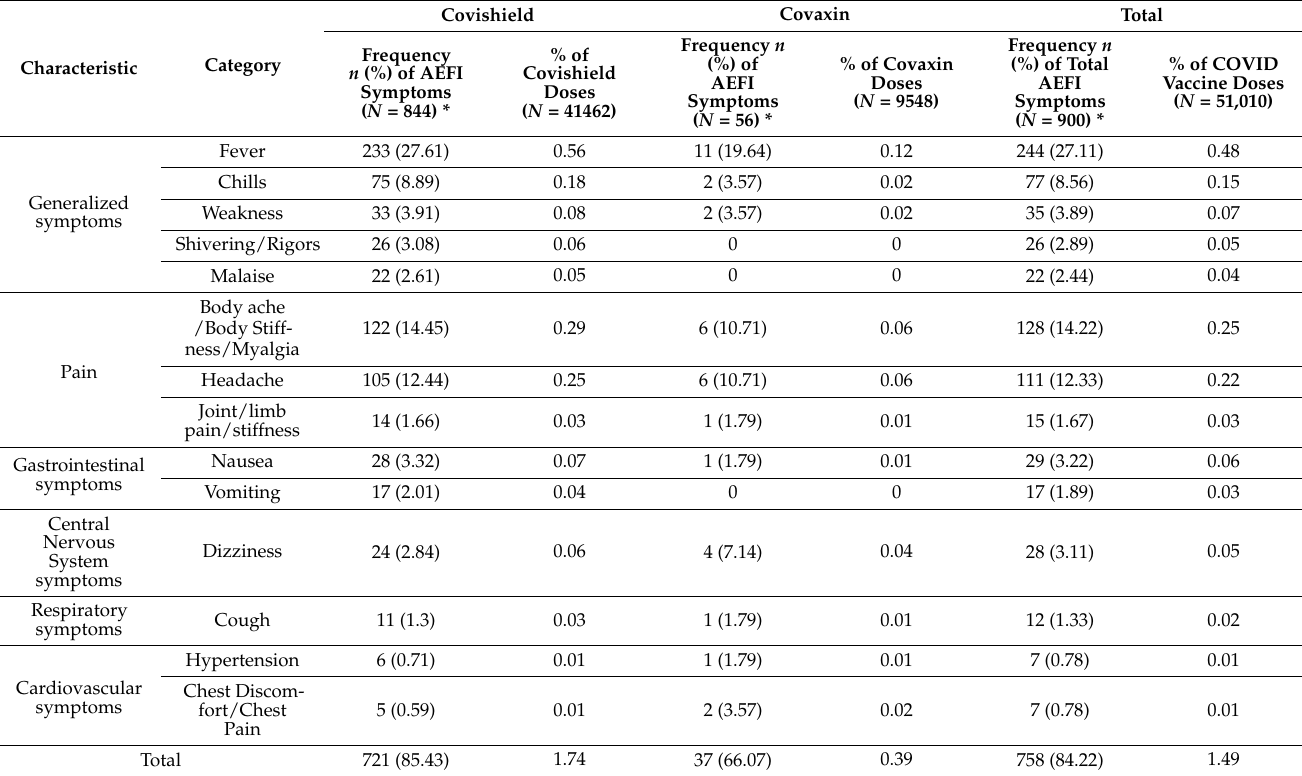
Table 4. Most frequent systemic AEFI with COVID-19